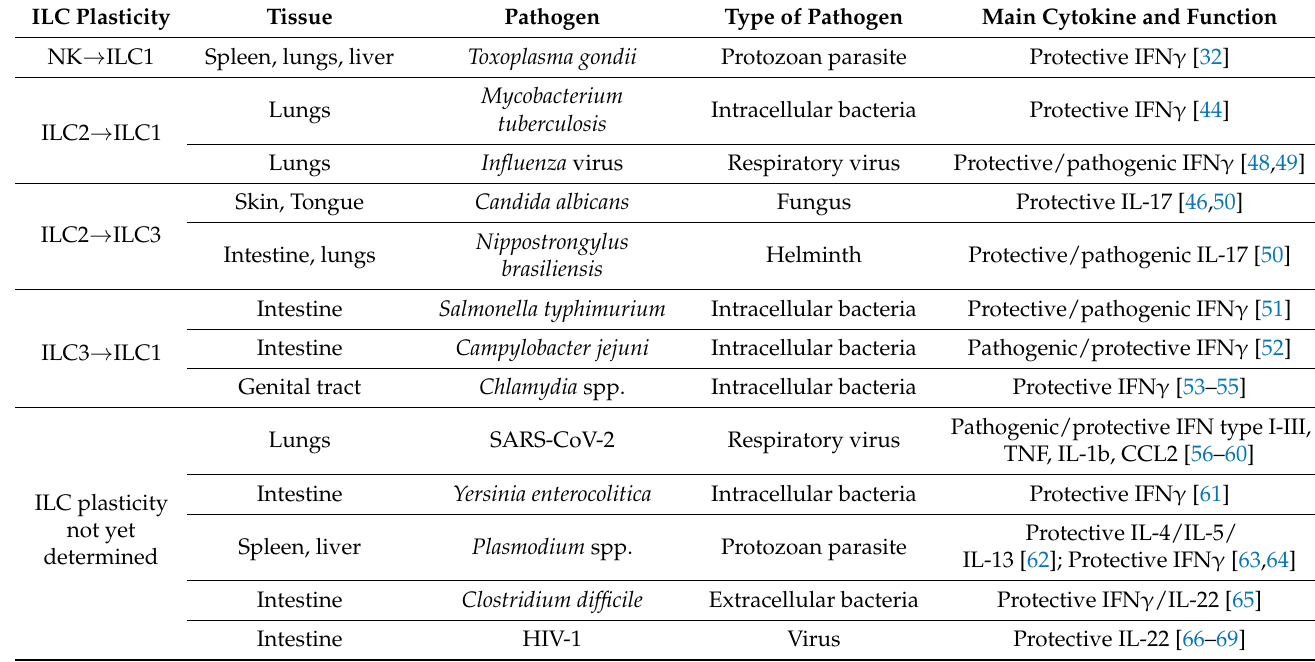
Table 1. ILCs plasticity in response to